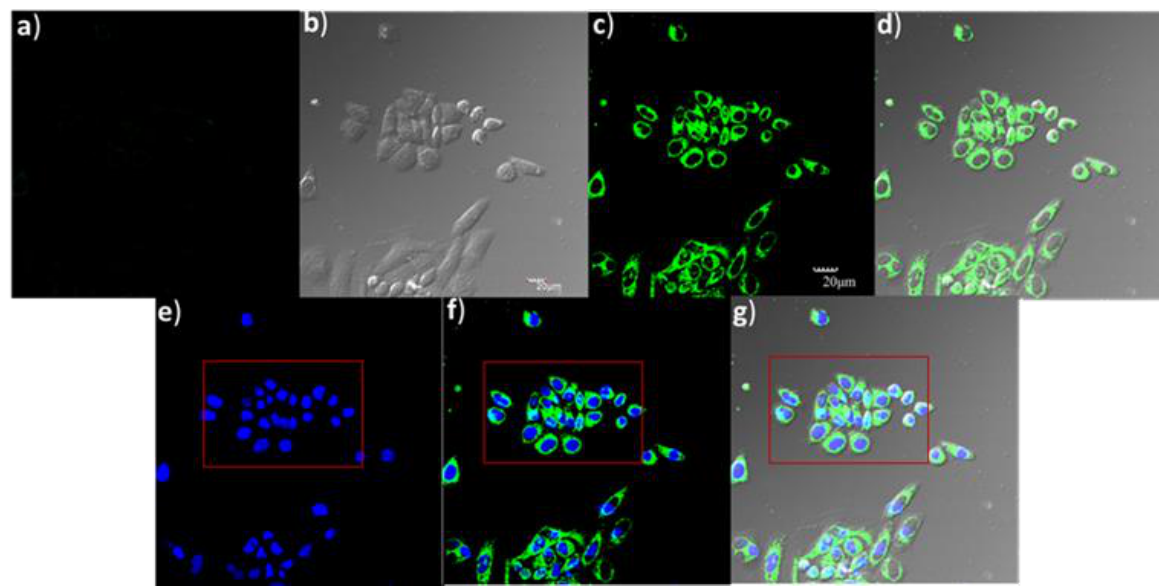
Figure 6. Confocal fluorescence images of Hl-7701 cells. ( a ) cells incubated with P ( 10 μM ) for 30 min in the growth medium; ( b ) bright field image of cells in panel ( a ); ( c ) cells supplemented with Mg 2+ ( 1 μM ) for 30 min, and then incubated with P ( 10 μM ) for 30 min; ( d ) overlay field image of cells in panel ( b , c ); ( e ) cells treated with Hoechst 33,342 (1 µg·mL − 1 ) for 30 min; ( f ) overlay of images in panel ( c , e ); ( g ) overlay field image of cells in panel ( b , c , e ) (λ ex = 850 nm).